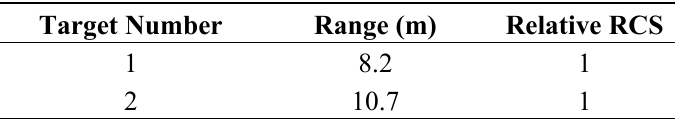
Table 3. Target Scenario